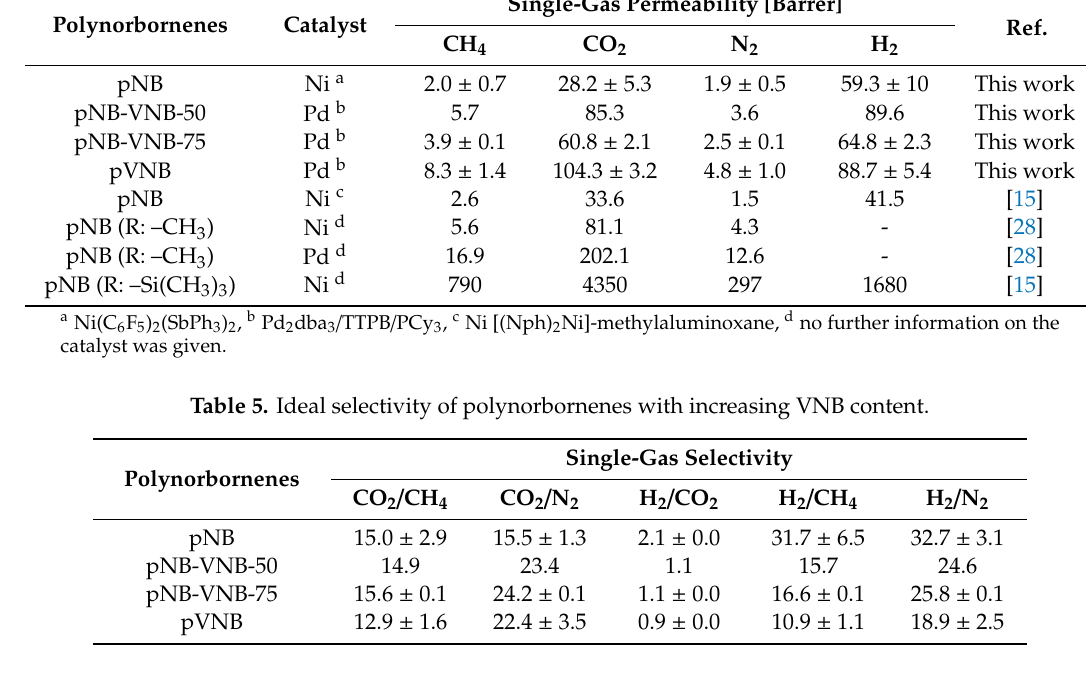
Table 4. Single-gas permeability data of polynorbornenes with increasing VNB content after 100 days of aging and other polynorbornenes with different side groups (R) performances.